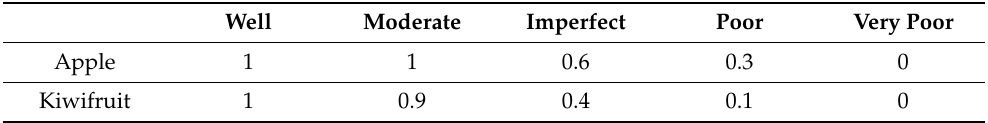
Figure 7 . Rooting depth score vs. potential rooting depth (PRD) for both apple and kiwifruit. A higher score indicates a more suitable PRD. Table 3. Drainage scores assigned to drainage class descriptors for different